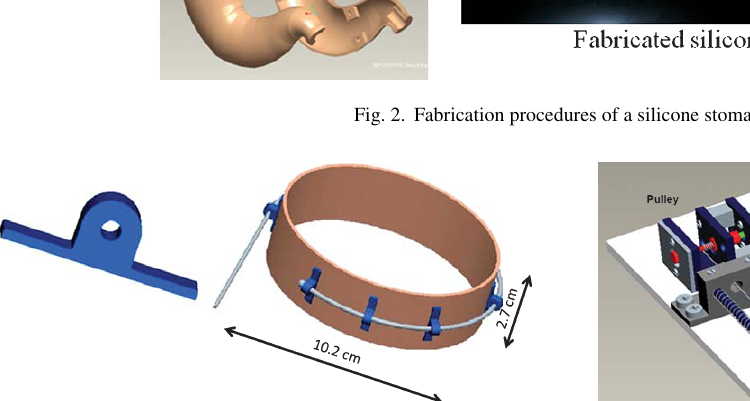
where (cid:1) is the relative occlusion of ACW, r is the occlu- sion radius and R is the radius without contraction.